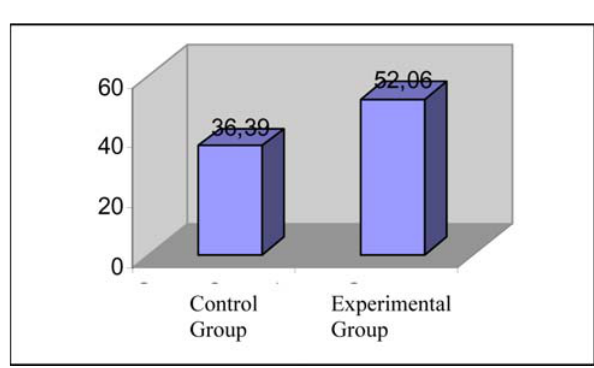
FIGURE 7 - Mean percentages of necrosis in the seventh postoperative day (%).